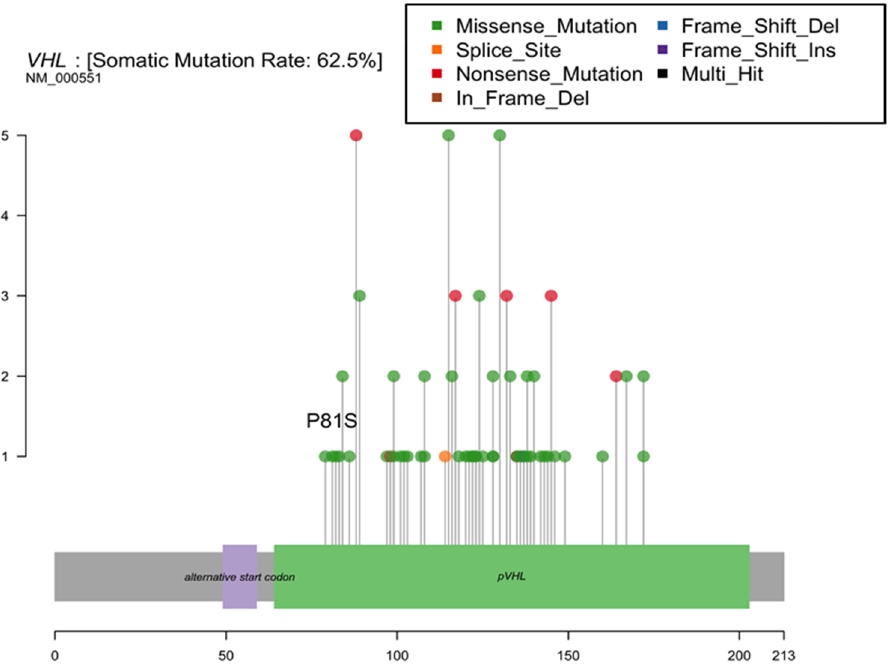
Figure 3. Von Hippel Lindau (VHL) gene mutations identified in New Hampshire patient renal cell carcinomas.